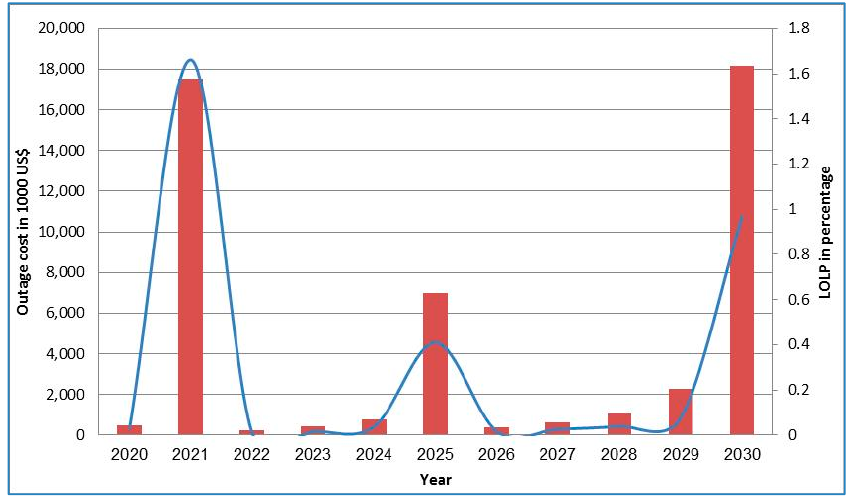
Figure 14. LOLP and OC in a scenario with LOLP = 1% and VOLL $2 USD/kWh.